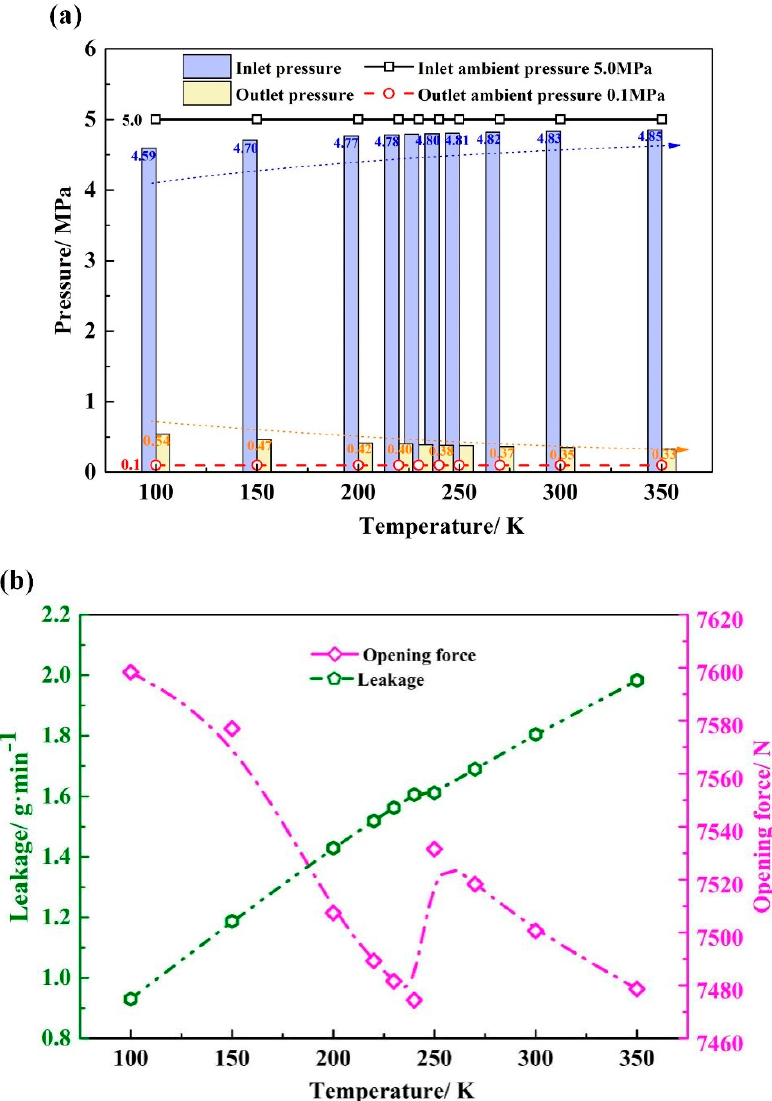
Figure 10. Relationship between the sealing performance and the sealing temperature. ( a ) Pressure boundaries between the seal rings; ( b ) Opening force and leakage. ( P in = 5.0 MPa, P out = 0.1 MPa, T out = 350 K, n = 50,000 rpm, h 0 = 3 μ m).